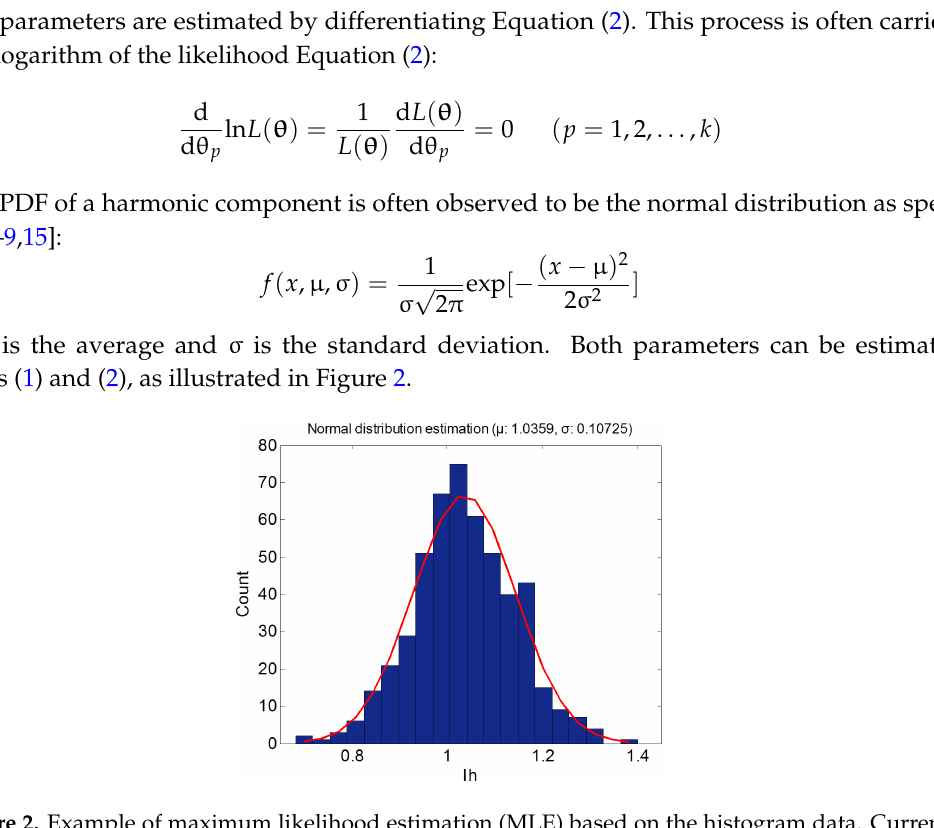
Figure 2. Example of maximum likelihood estimation (MLE) based on the histogram data. Current measurement at a certain harmonic order takes the normal distribution for which the parameters of the average and standard deviation are